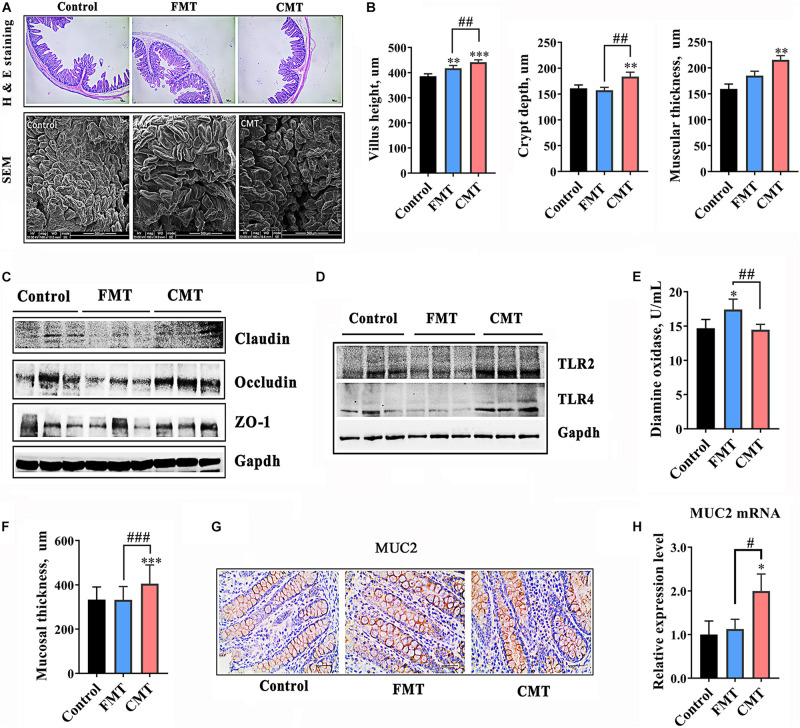
CMT improved development and immune function of the gut in piglets. (A) Hematoxylin-eosin staining images (40 × magnification) and scanning electron microscope images (300 × magnification) of ileal sections from piglets on day 28. (B) Development index of the ileum (height of ileal villi, depth of ileal crypts, and muscular thickness). (C) Protein levels of tight junction proteins in the ilea of piglets. The expression levels of proteins were analyzed by western blotting. (D) Protein levels of toll-like receptor 2 and 4 (TLR2 and TLR4) in the ilea of piglets. (E) Diamine oxidase content in the blood of piglets. (F) Mucosal thickness in the colons of piglets. (G) Immunohistochemical staining of the Mucin 2 (MUC2) protein in colonic sections. (H) mRNA level of MUC2. The expression level was detected by qRT-PCR (n = 6). The data are presented as the mean ± S.D. ∗∗∗ Indicates P < 0.001; ∗∗ indicates P < 0.01, and ∗ indicates P < 0.05 compared with the control; ### indicates P < 0.001, ## indicates P < 0.01, and # indicates P < 0.05 between the FMT and CMT groups.